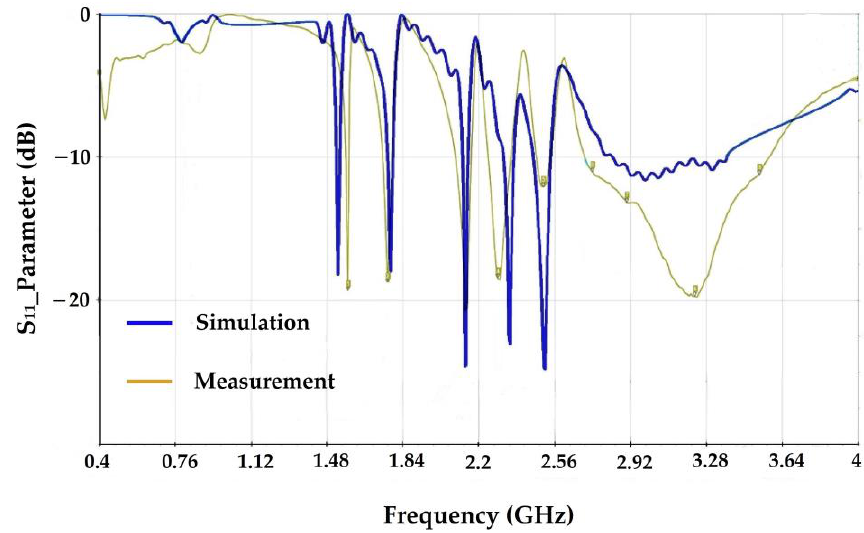
Figure 6. The simulated and measured S 11 parameter of the proposed antenna.